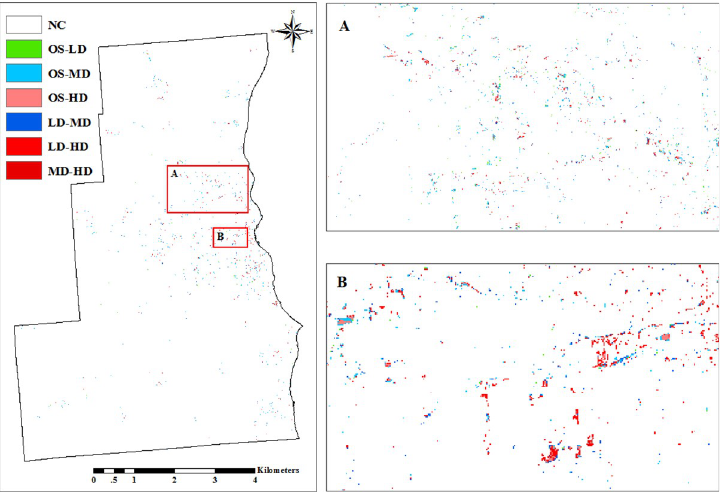
Fig 4. Urban density transition maps between 2001 and 2011. (A) Urban density transition far from the historical center. (B) Urban density transition near the historical center.NC means no change, and labels of the form XX-YY indicated that XX transitioned to